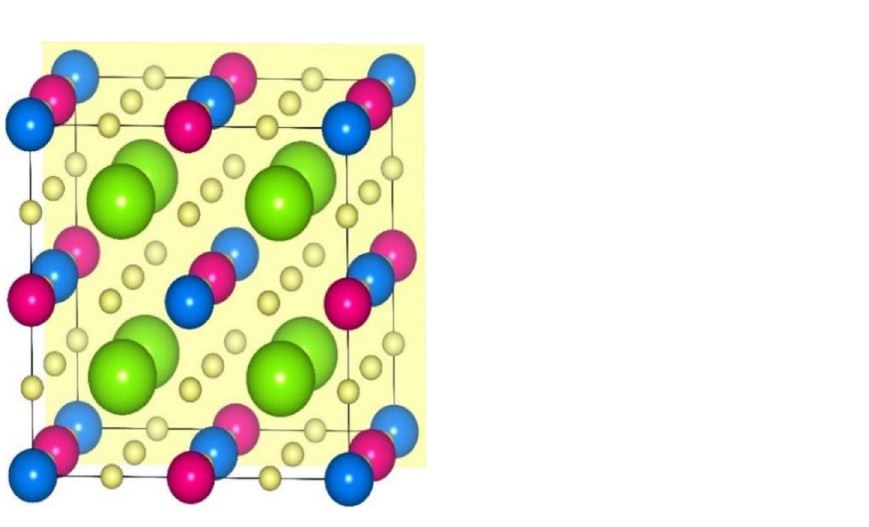
Figure 1. Distinct position of respective atoms of Ba 2 ErNbO 6 and Ba 2 TmNbO 6 molecular crystal structures: Green (Ba), Blue (Er/Tm), Pink (Nb) and Yellow